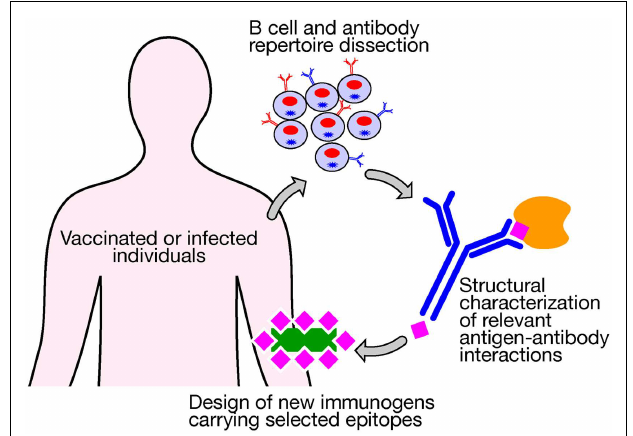
FIGURE 2 | New technologies aimed at interrogating the human B cell repertoire after vaccination or infection are providing for the first time the possibility of isolating broadly neutralizing antibodies that target relevant conserved epitopes . A structural characterization of an antigen in complex with protective antibodies represents the launching point for the design of new immunogens bearing selected relevant protective epitopes to be used for